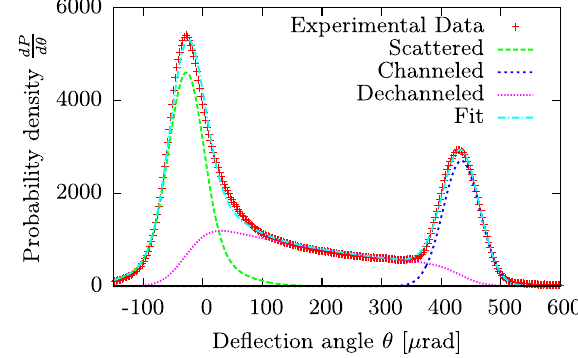
FIG. 9. The probability density of the deflected particles when the crystal is at half of the full bending angle. The large leftmost peaks are the volume reflected portions and the small rightmost peaks are the volume captured particles.